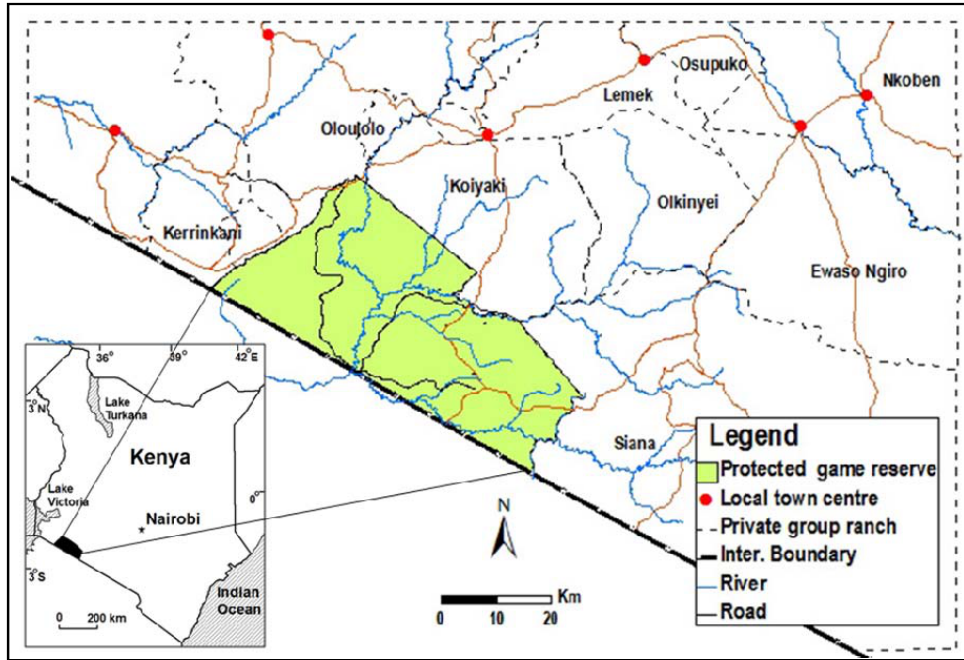
Figure 1. Map of the study area showing the Masai Mara National Reserve and the surrounding privately owned group ranches.